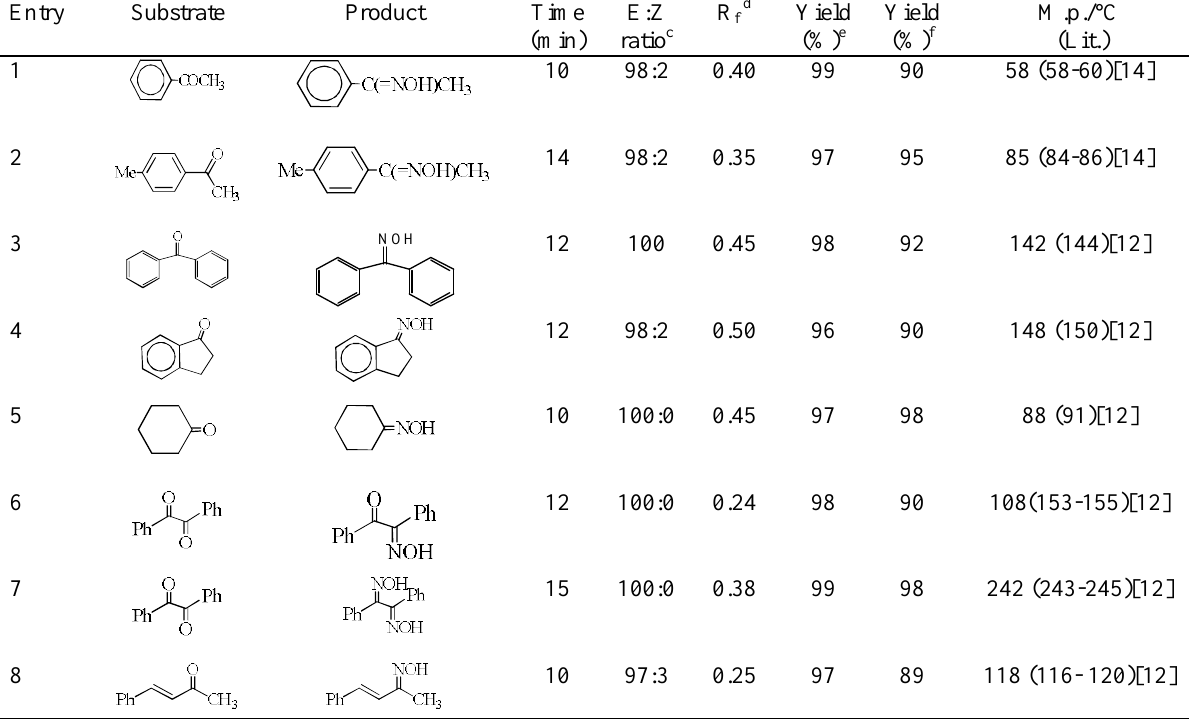
Nano Composite System a , b